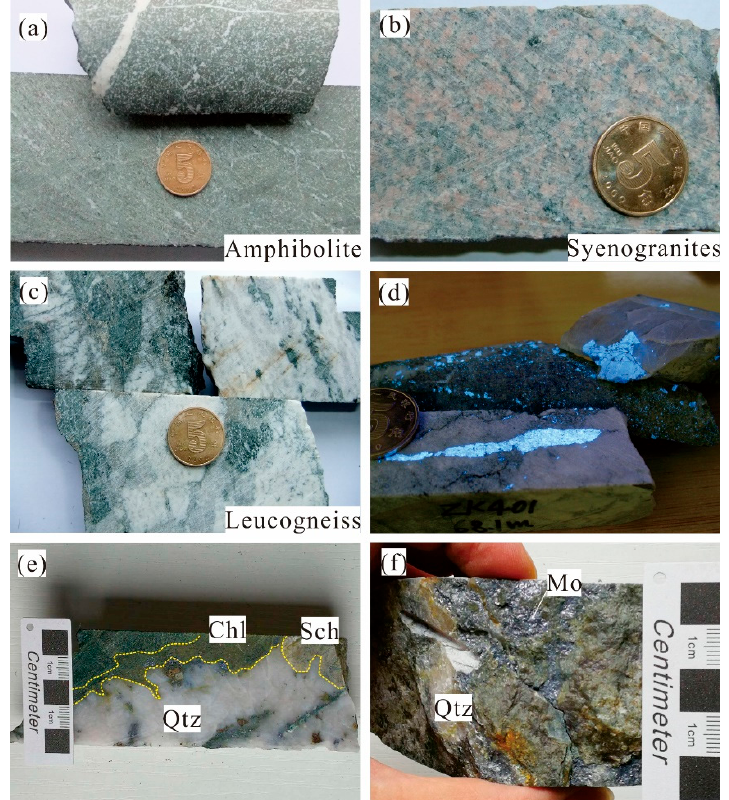
Figure 3. Representative photographs of rock, hydrothermal alteration, and mineralization features in the Shangfang W deposit. ( a ) amphibolite; ( b ) biotite syenogranite; ( c ) leucogneiss; ( d ) photographs under ultraviolet light showing massive and disseminated scheelite; ( e ) syn ‐ ore scheelite–quartz veinlets within the chlorite ‐ altered amphibolite; ( f ) molybdenite along cleavage of quartz veinlet. Abbreviations: Qtz = quartz; Sch = scheelite; Chl = Chlorite; Mo = molybdenite.